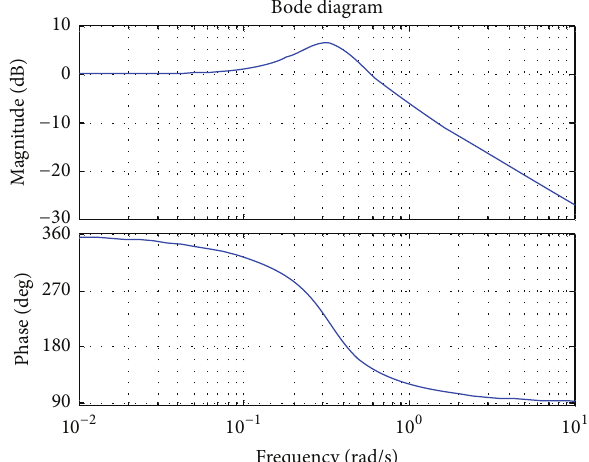
Figure 7: The Bode diagram for Example 7.